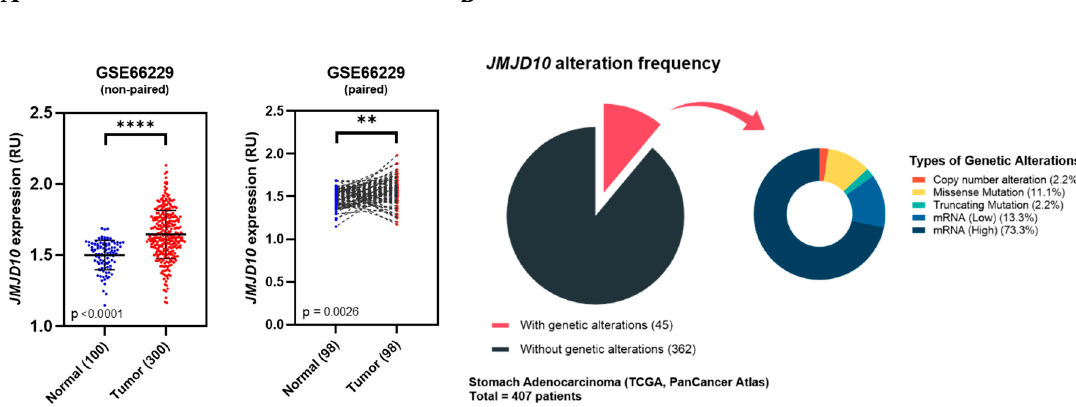
Figure 2. JMJD10 gene expression in gastric tumor microarray GSE66229 and genetic alteration profiling of JMJD10 in stomach adenocarcinoma TCGA PanCancer Atlas 2018. ( A ) Pairwise and non-pairwise comparison of JMJD10 expression between normal vs. tumor from dataset GSE66229 (RU: Relative Unit). ( B ) Alteration frequency analysis of the JMJ10 gene in stomach adenocarcinoma patients from TCGA PanCancer Atlas database extracted from the cBioPortal.